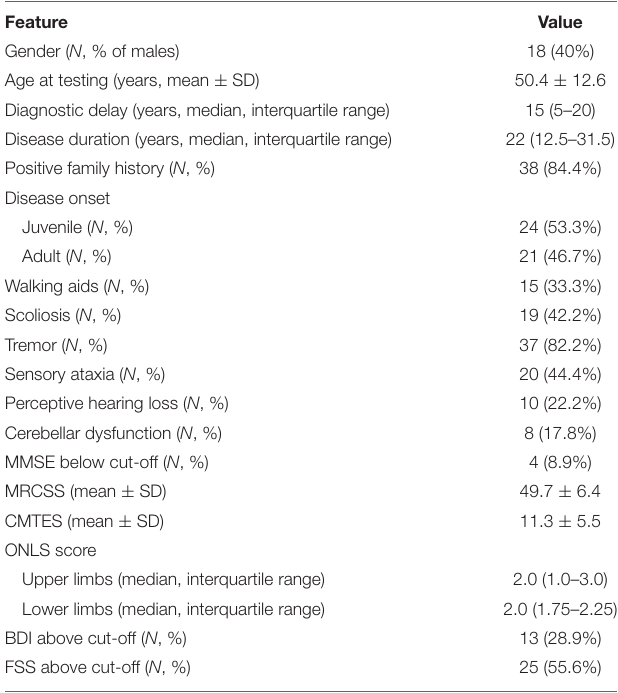
TABLE 1 | Main sociodemographic and clinical features of patients with CMT1A ( n =